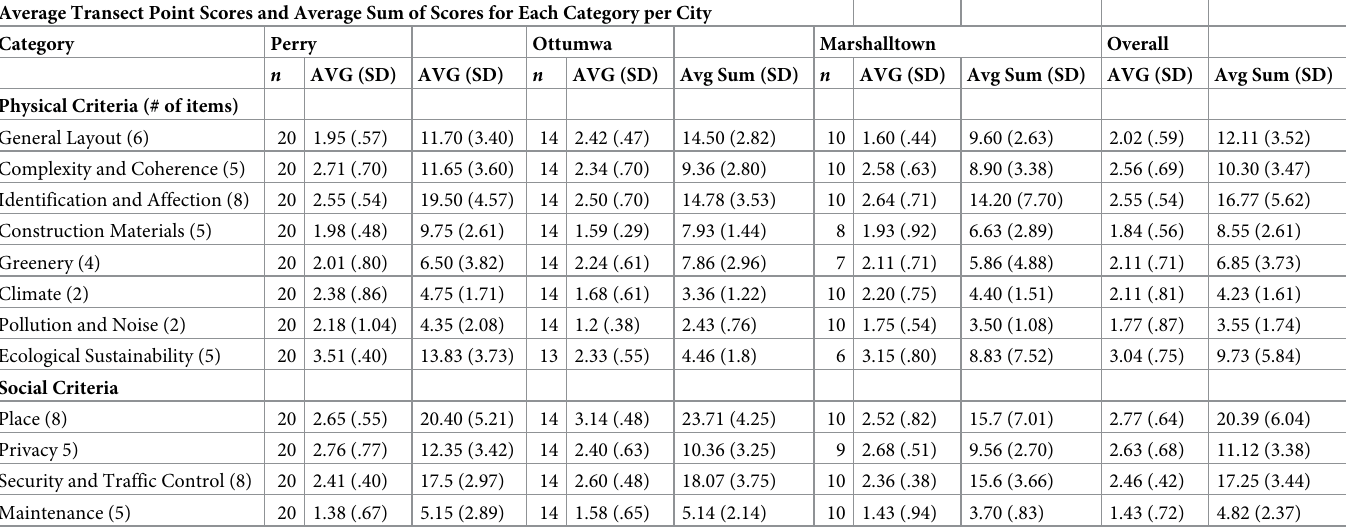
Each group has multiple measures of evaluation, 2–8, as indicated in the parentheses, so the mode of each item was averaged into its group criteria. Average sums illustrate the highest negative value, i.e. I strongly disagree that this area is well organized (4), so the 6-item general layout could have a range from 6 of meets environmental design criteria to 24 of severely